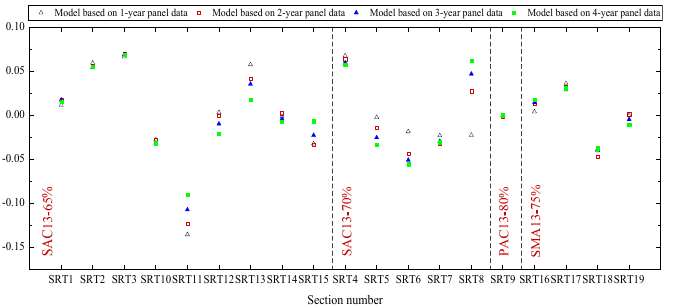
Figure 6. Random error component ( u i ) of surface texture prediction model based on different time scales of SMTD data.